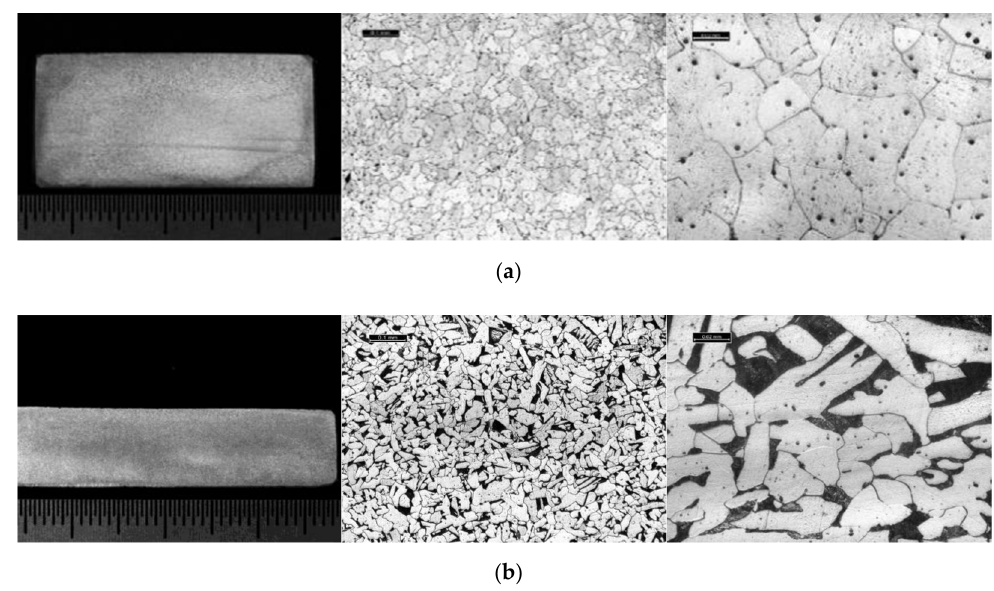
Figure 8. Macrographic and micrographic results for both studies. ( a ) From left to right: Macrographic, micrographic 100 × , micrographic 500 × “Bemb é zar” Stringer sample; ( b ) From left to right: Macrographic, micrographic 100 × , micrographic 500 × “Corbones” Stringer sample.